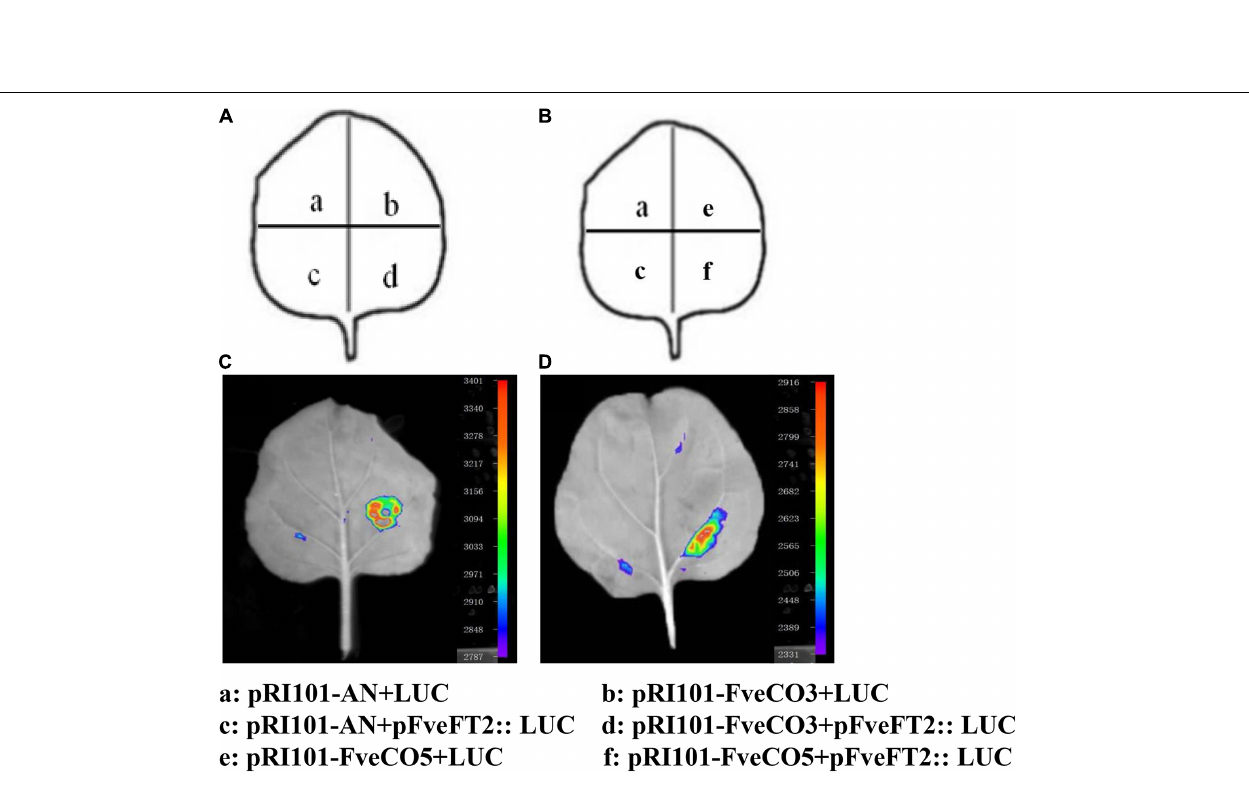
Frontiers in Plant Science |